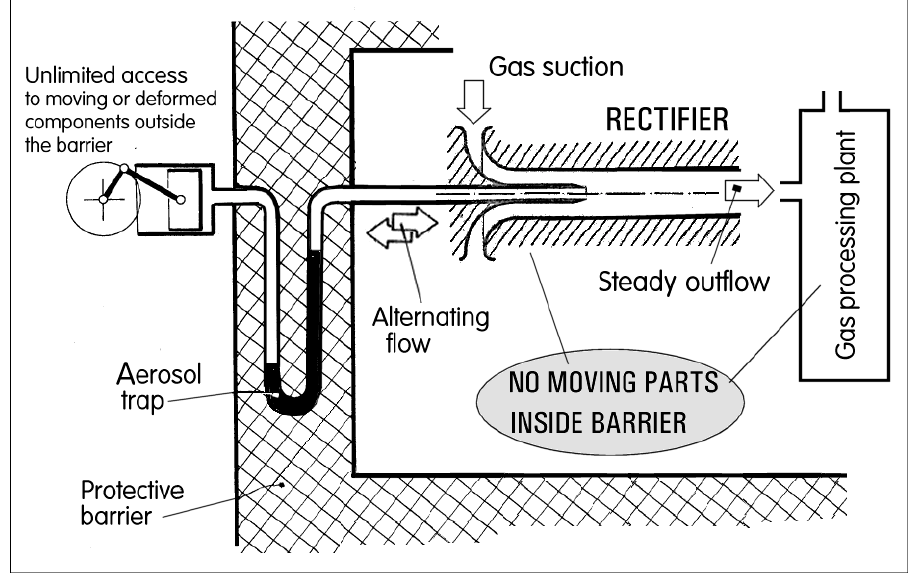
Figure 1. Representation of the transferring power into an inaccessible space behind a protective barrier, where an is handled an extremely dangerous fluid. The alternating input flow into the no-moving-parts fluidic rectifier is the only way to securing behind the barrier both full safety and no need of moved (piston) or deformed (springs) mechanical components behind the barrier.